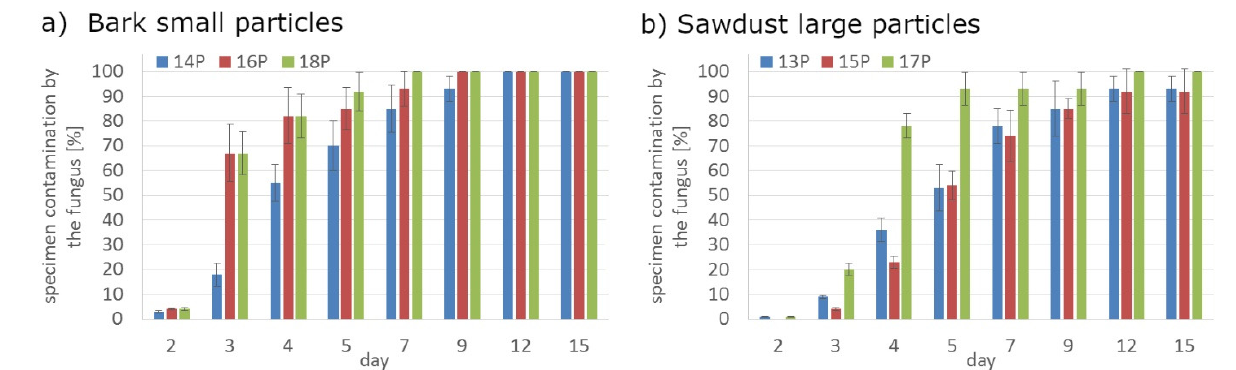
Figure 7. Porosity of the tested PLA and HDPE composites.